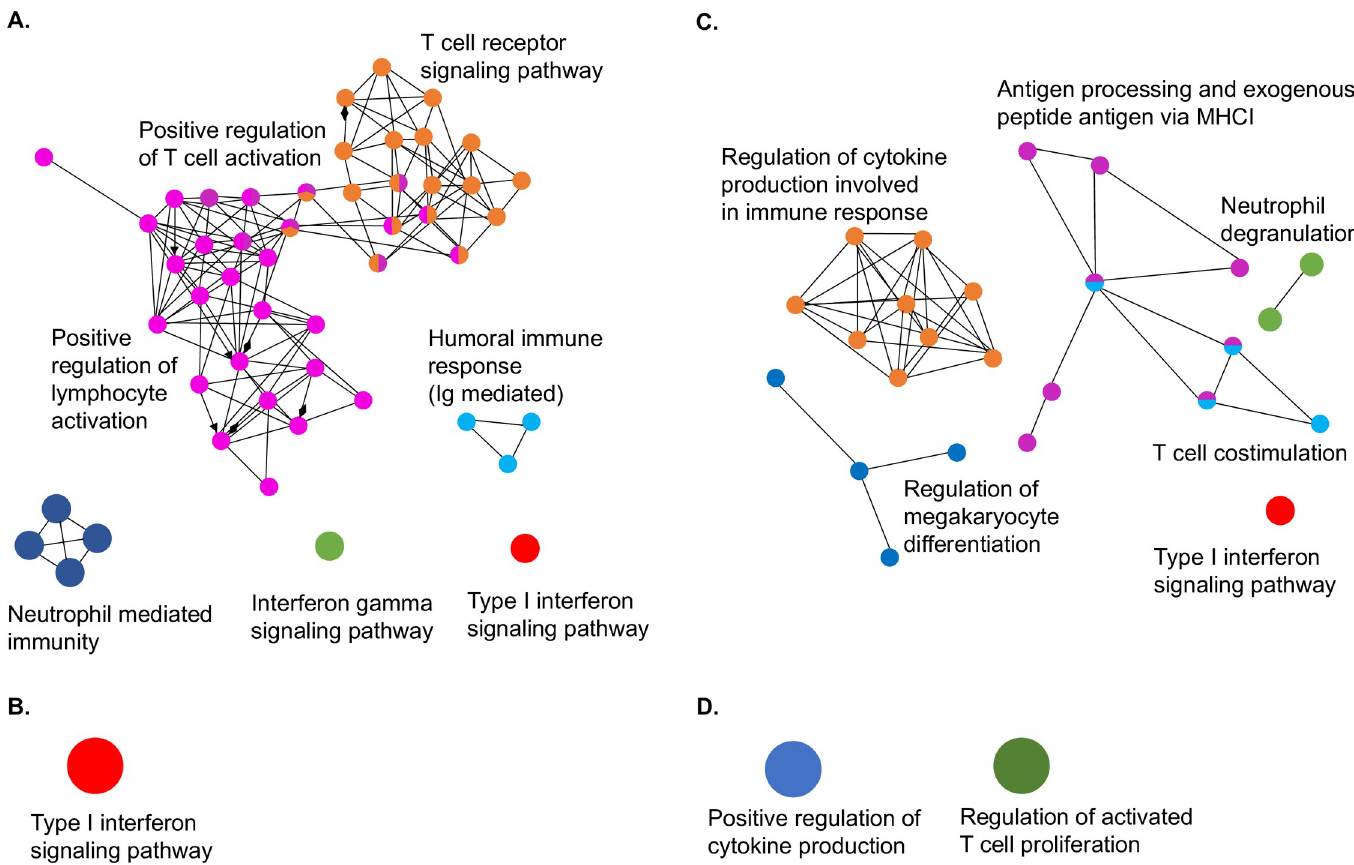
Fig 5. GO analysis of proteomics data showing upregulated pathways in bat and ferret lung. Upregulated pathways following HeV infection (60 hpe) compared to uninfected (0 hpe). Bat lung: ( A ) BB1 and ( B ) BB2. Ferret lung: ( C ) FF1 and ( D ) FF2.